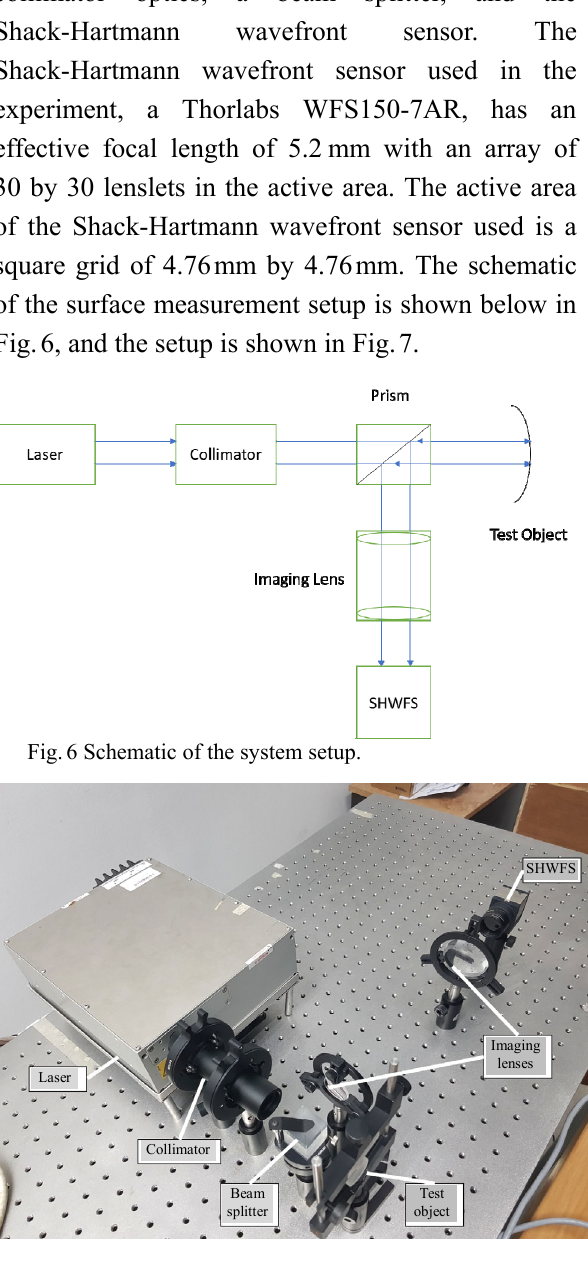
Fig. 7 Experimental setup.